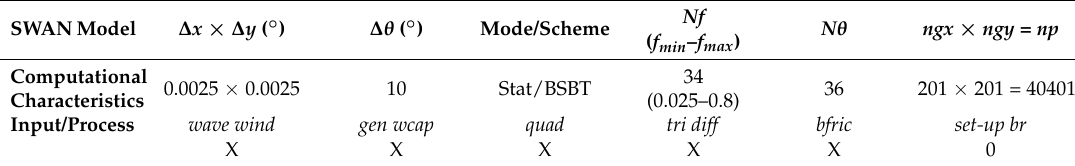
Table 1. Description of the computational characteristics and the physical processes activated in the SWAN model simulations. X means that the process is activated and 0 means no process.